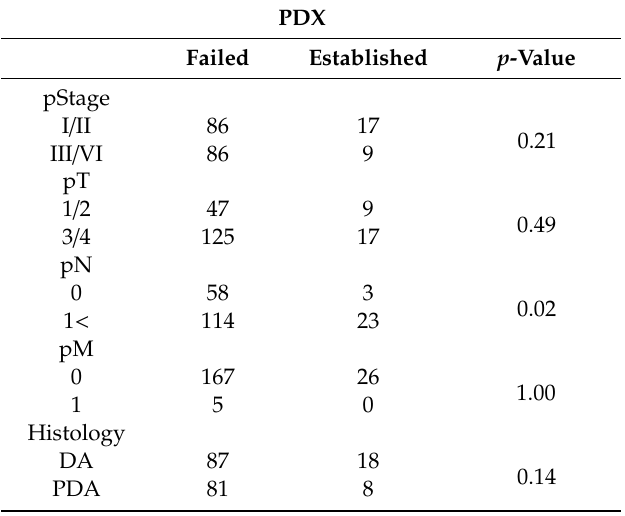
Table 7. Pathological factors related to PDX